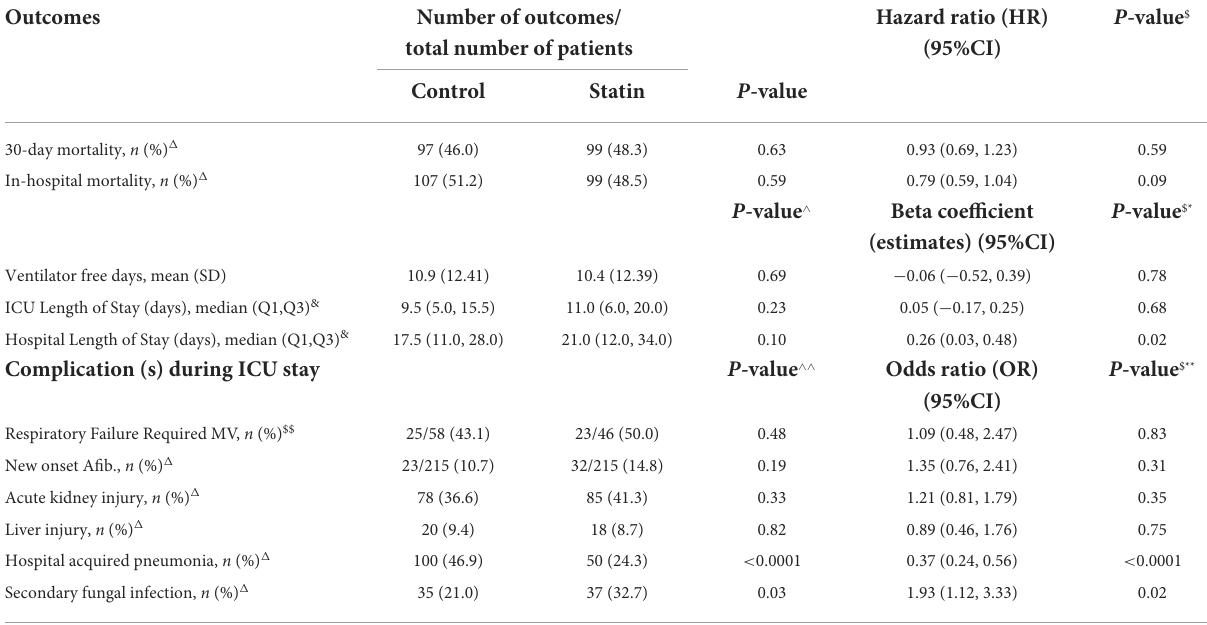
TABLE 4 Subgroup analysis—regression analysis for the outcomes after PS adjustment (chronic use of statin only).